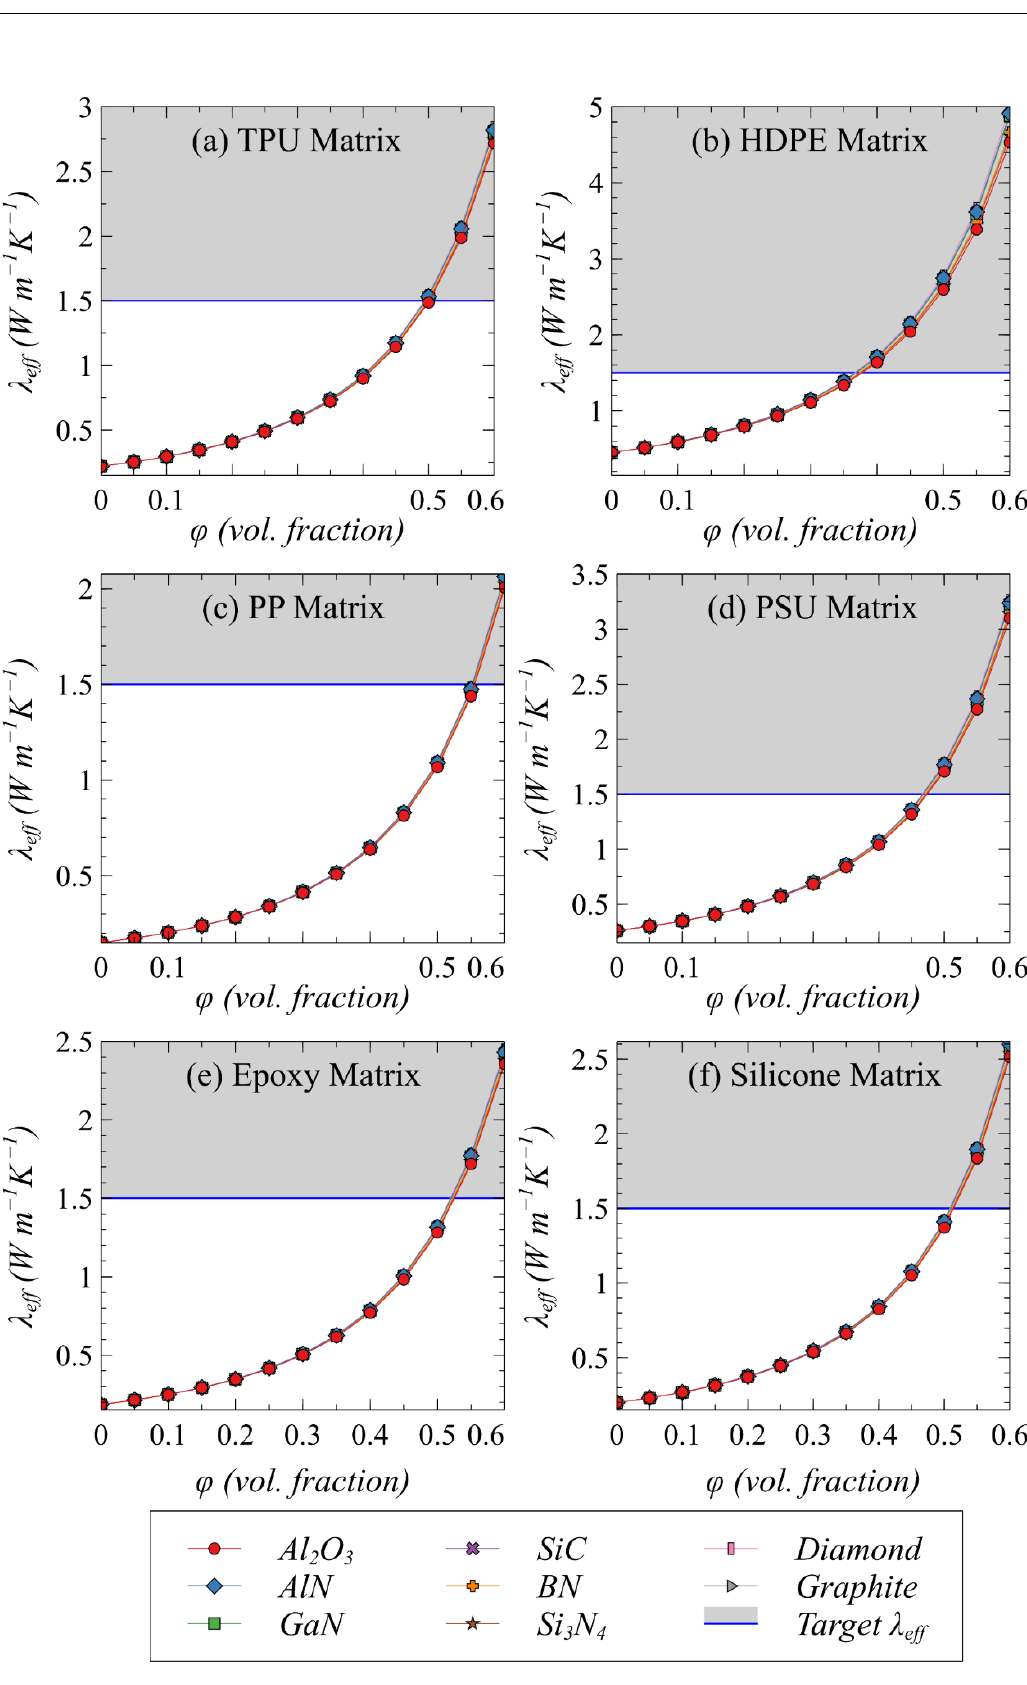
Figure 3. The predicted effective thermal conductivity of composites with different polymer–filler combinations at R int / a k = 0.1.